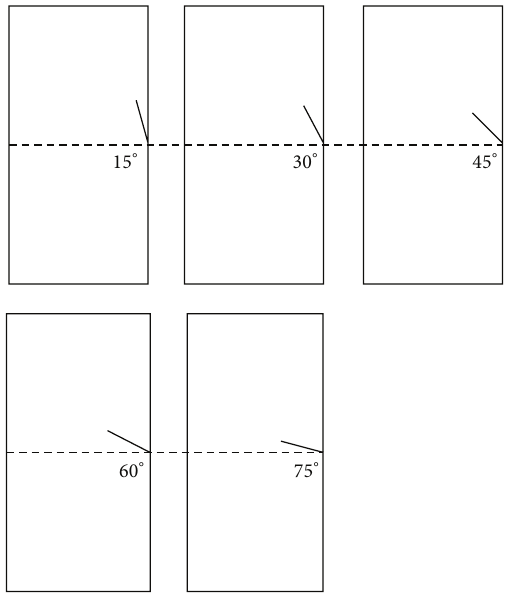
Figure 1: Diagram of the testing